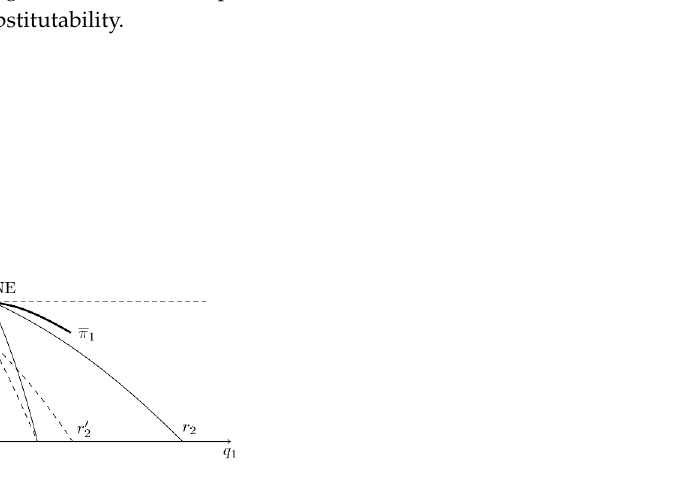
Figure 5. Owner 1’s Incentive to Hire a CEO Who Overestimates Product Substitutability in the Figure 5. Owner 1 ʹ s Incentive to Hire a CEO Who Overestimates Product Substitutability in the Cournot Model When Overestimation Affects the Best ‐ Reply Curves of Both Firms. Cournot Model When Overestimation Affects the Best-Reply Curves of Both